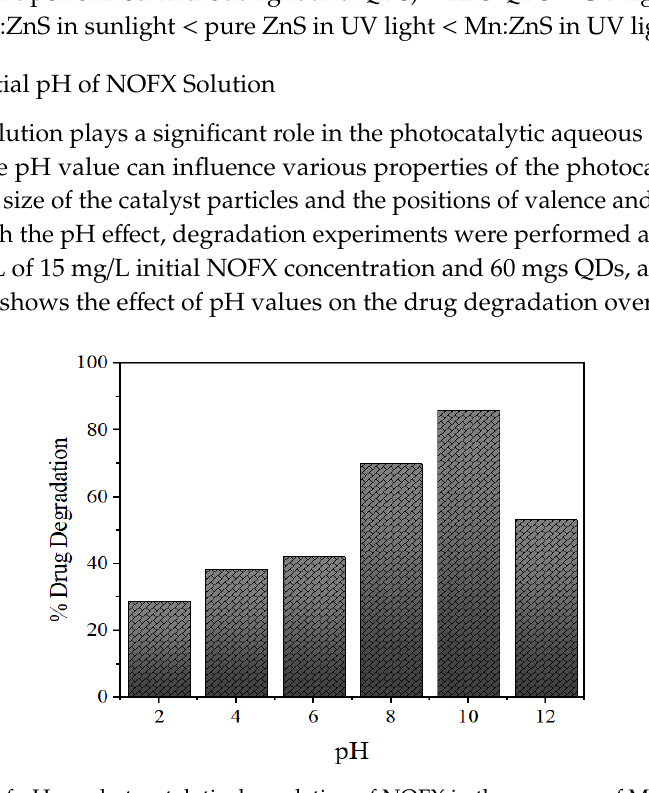
Figure 12. Effects of pH on photocatalytic degradation of NOFX in the presence of Mn:ZnSQDs under optimal conditions (25 mL of NOFX, 60 min irradiation, 60 mgs QDs).